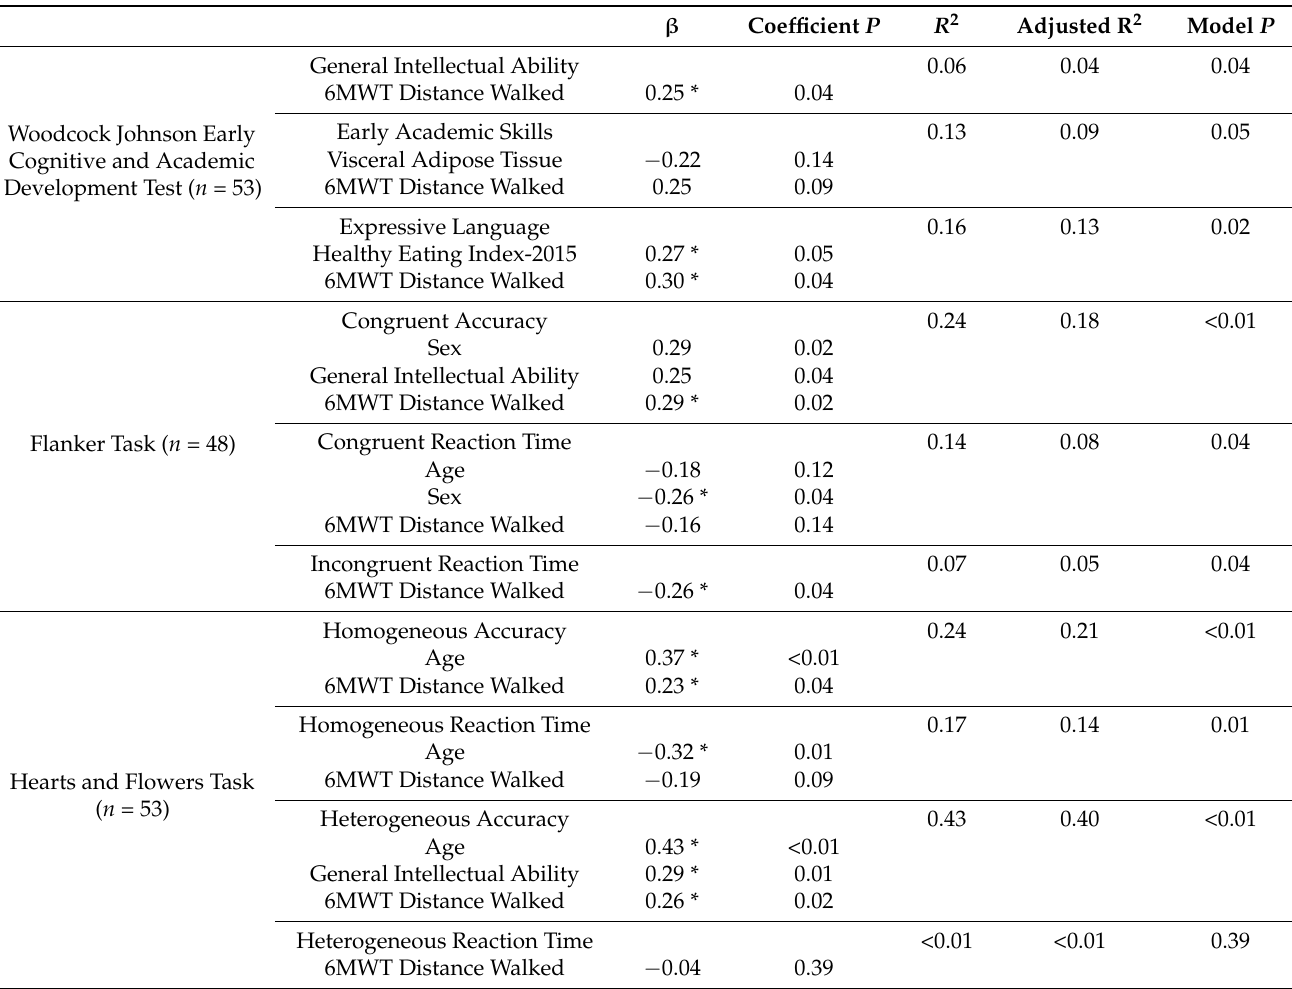
Table 2. Regression analyses describing the association between six-minute walking test (6MWT) distance walked and academic skills and cognitive abilities among preschool-aged children. β Coefficient P R 2 Adjusted R 2 Model P